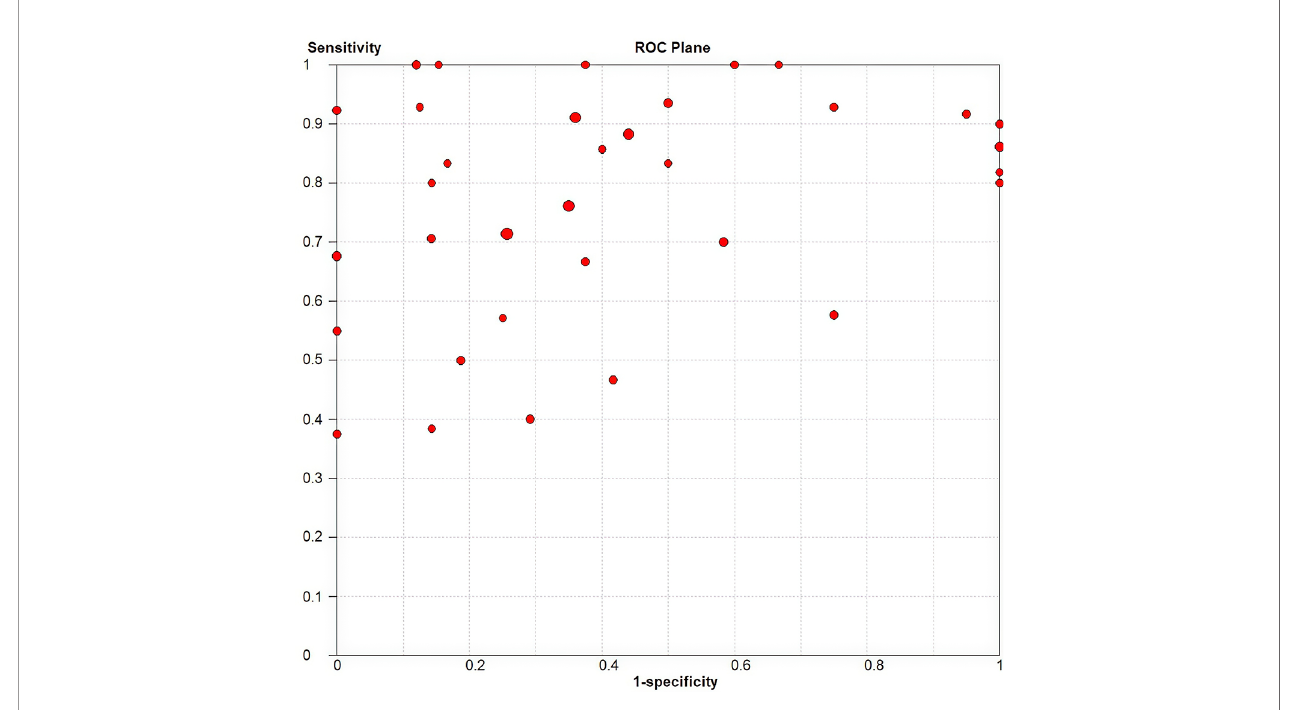
FIGURE 4 | The ROC plane for assessing threshold effects.